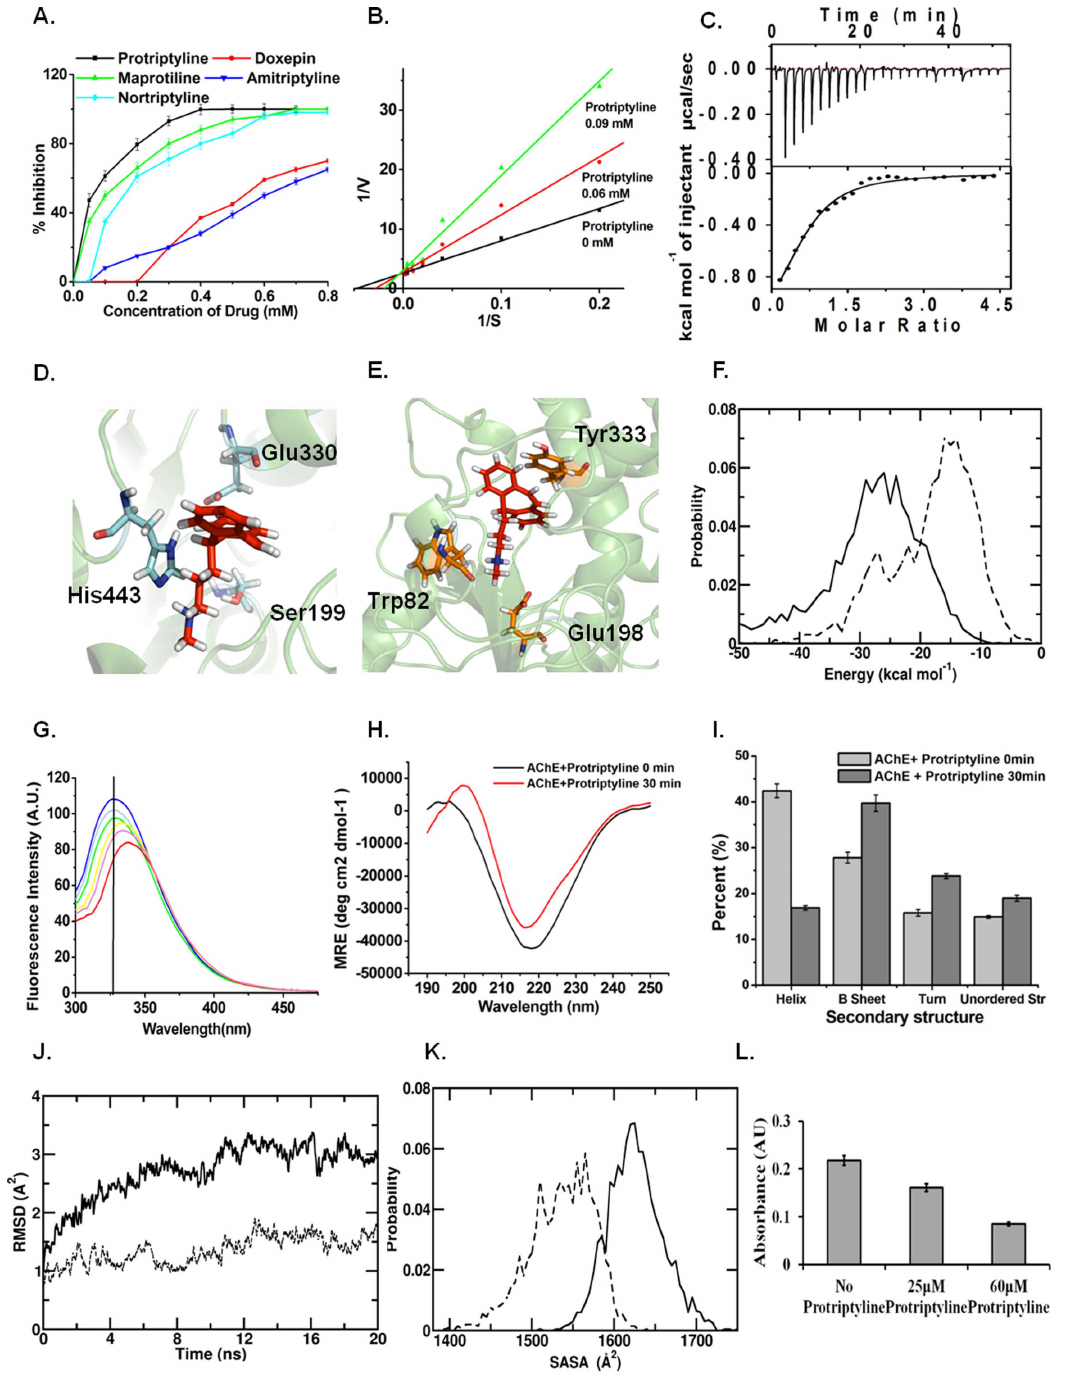
Figure 2. Protriptyline inhibits AChE activity. A . Determination of IC50 values of five drugs for AChE by using 0.05–0.8 mM concentration range of all the drugs B . Estimation of the kinetic constants by Lineweaver–Burk analysis. AChE inhibition by protriptyline showed competitive inhibition. C . Isothermal Titration Calorimetric analysis of protriptyline – AChE interactions. The upper panel shows the raw data in the form of heat effect during titration and the lower panel shows corresponding thermogram representing the best fit curve D . Snapshot of drug binding with catalytic subsite of AChE E . snapshot of drug binding with anionic subsite of AChE F . Distribution of Protriptyline –anionic subsite (solid line) and Protriptyline –esteratic subsite (broken line) nonbonded (nonb) interaction energy; data are averaged over last 20 ns G . Fluorescence quenching of AChE by protriptyline H . CD spectra of binding of protriptyline to AChE and I . CD pro analysis to study the conformational change J . Evolution of the backbone RMSD for the Protriptylline bound (solid line) and free (broken line) AChE active sites from MD trajectories K . SASA distributions of active sites for Pro-bound (solid line) and free (broken line) AChE active sites from MD trajectories L . Measurement of AChE activity after treatment of neuro2a cells with 25 m M and 60 m M protriptyline for 15 h.